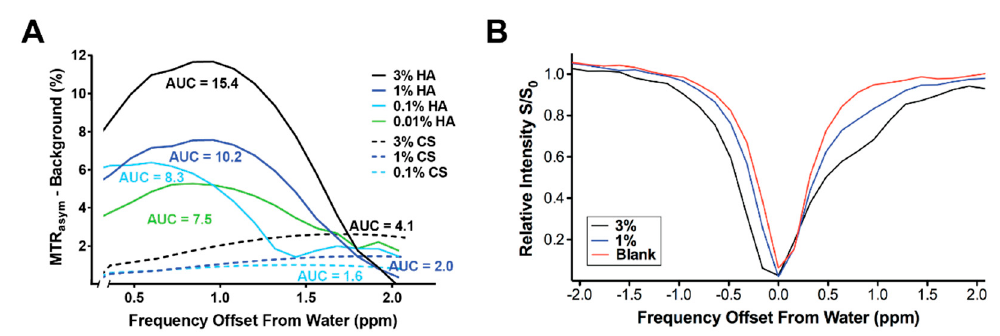
Figure 4. Chondroitin sulfate (CS) and hyaluronic acid (HA) phantom GagCEST characterization at 14T. ( A , B ) Magnetization transfer ratio (MTR) asymmetries of CS and HA suspensions minus background. Representative intensity curves from chondroitin sulfate suspensions (1% and 3%) and aqueous blank. Area under the curve (AUC) increased with greater CS and HA content. Note the greater amount of signal generated by HA versus CS, even at 10-fold lower concentration.